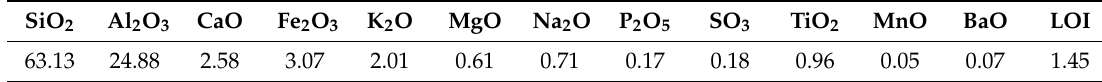
Figure 1. XRD patterns of fly ash and nanosilica particles. Table 1. Chemical composition of fly ash (unit: wt%).